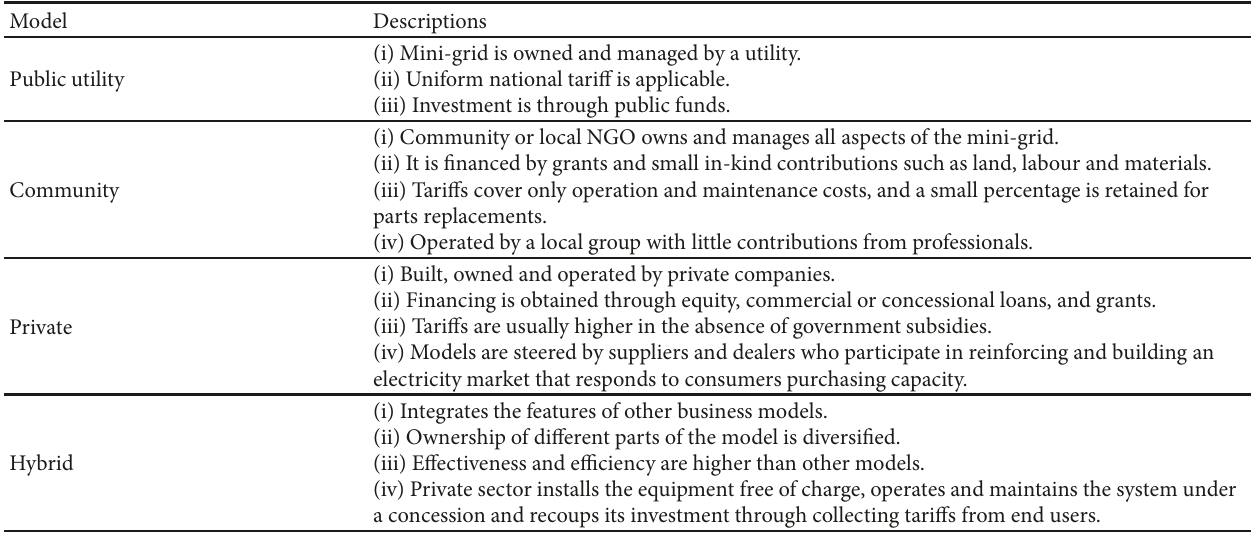
Table 1: Mini-grid business model